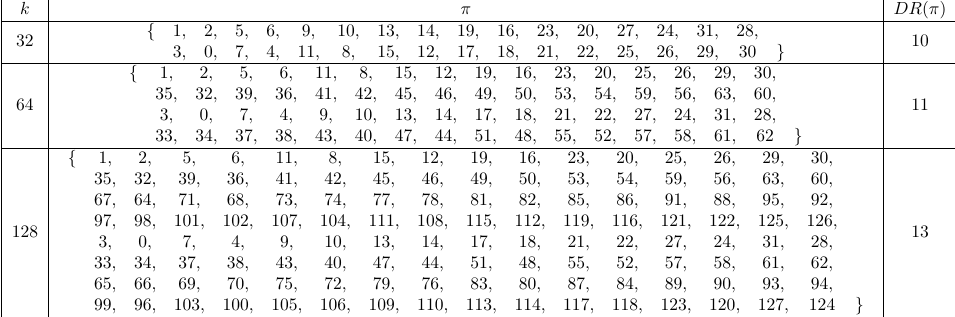
Table 7: Some even-odd permutations associated with T l